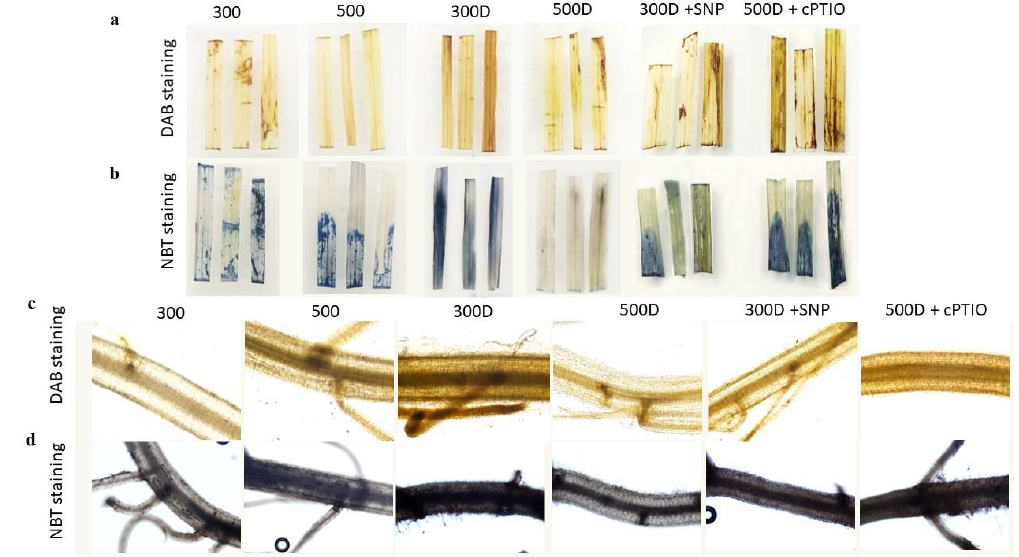
Figure 6 . Reactive oxygen species accumulation responses . Hydrogen peroxide accumulation detected by 3,3’ - diamino- benzidine ( DAB ) staining of ( a ) leaves and ( c ) roots . Superoxide radical accumulation detected by nitro blue tetrazolium ( NBT ) staining of ( b ) leaves and ( d ) roots of rice plants after 3 - day growth in the different NO - associated treatments .